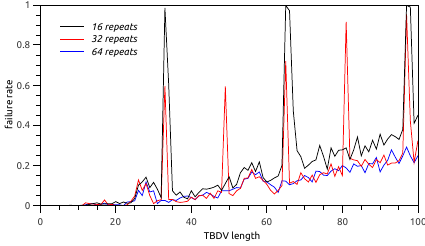
Figure 4: The failure rate of executing TBDVs with different lengths L.